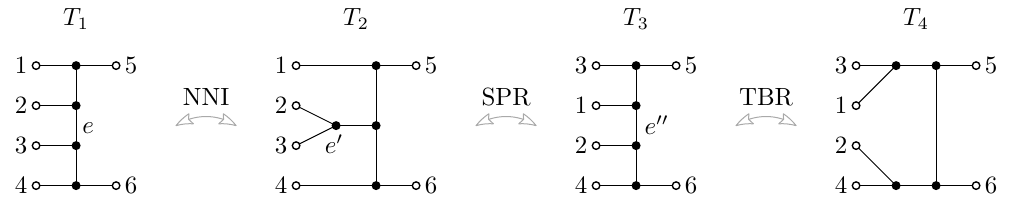
Figure 1: The three rearrangement operations on unrooted phylogenetic trees: The NNI from T to T changes the order of the four edges incident to e ; the SPR from T 1 2 prunes the edge e (cid:48) , and then regrafts it again; and the TBR from T the edge e (cid:48)(cid:48) , and then reconnects the resulting two trees with a new edge. Note that every NNI is also an SPR and every SPR is also a TBR but not vice